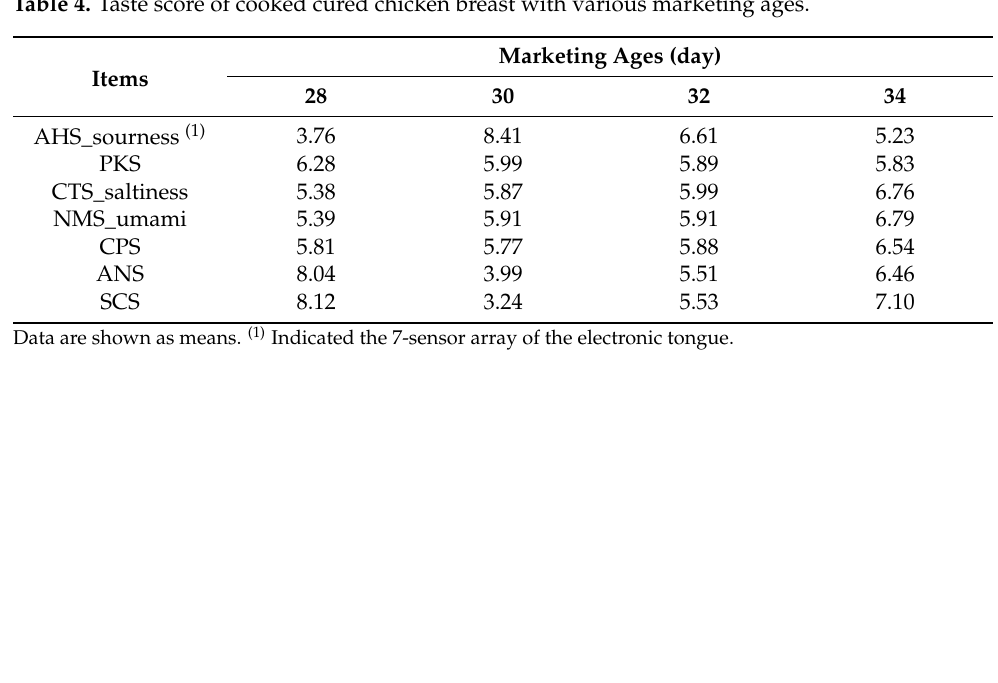
Table 4. Taste score of cooked cured chicken breast with various marketing ages. Items